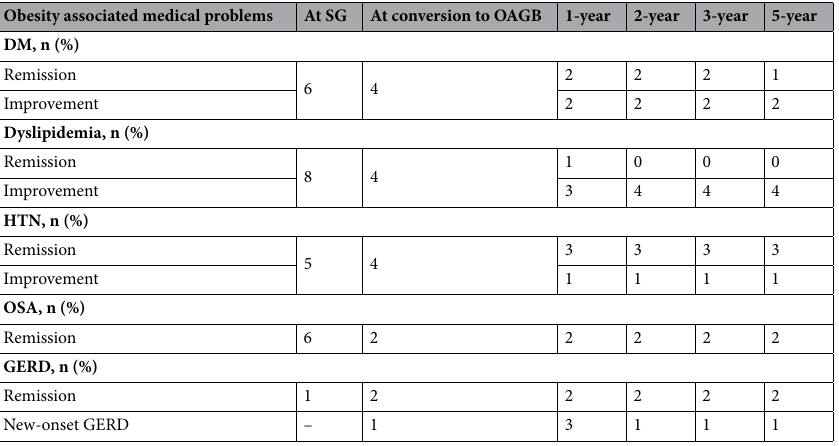
Table 2. Obesity associated medical problems at SG, at conversion to OAGB and 1, 2, 3 and 5-year follow up presented as frequency (descriptive test). DM diabetes mellitus, GERD gastroesophageal reflux disease, HTN hypertension, No number, OSA obstructive sleep apnea.